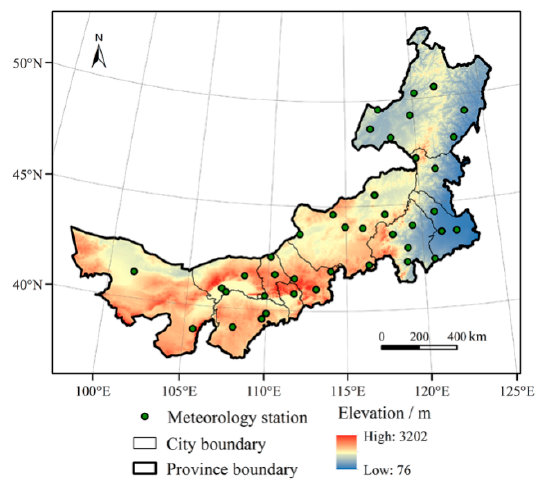
Figure 1. The elevation and distribution of meteorological stations in Inner Mongolia.